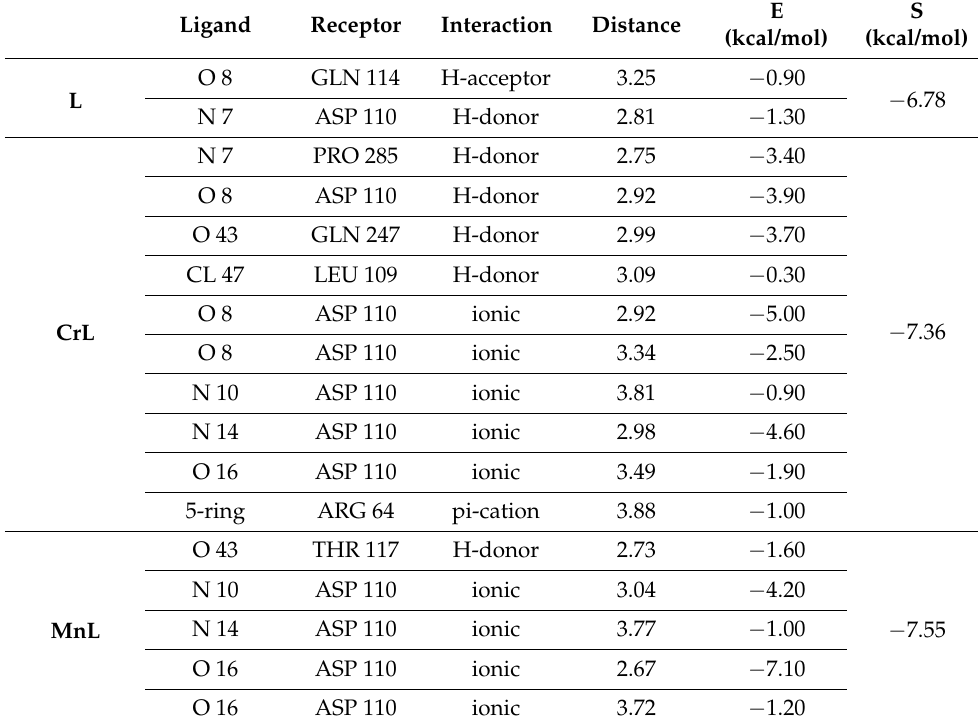
Table 2. Docking score obtained and corresponding interaction